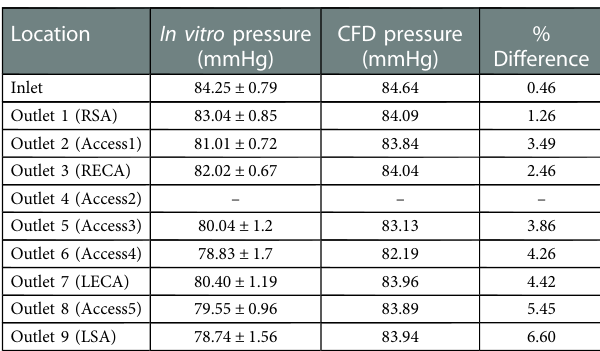
TABLE 2 Mean pressure (mmHg) obtained from in vitro experiments and CFD at various inlet and outlets for the normal condition. The experimental values are reported as mean±standard deviation (SD) from three